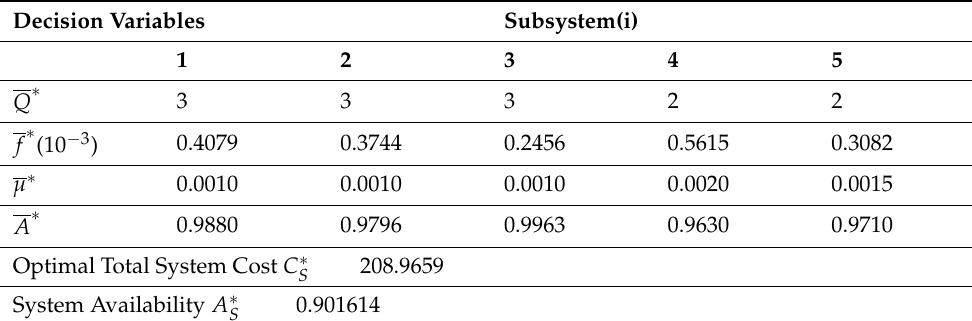
Table 24. Optimal Solutions obtained by MRAH–MGA for the parallel-series system.